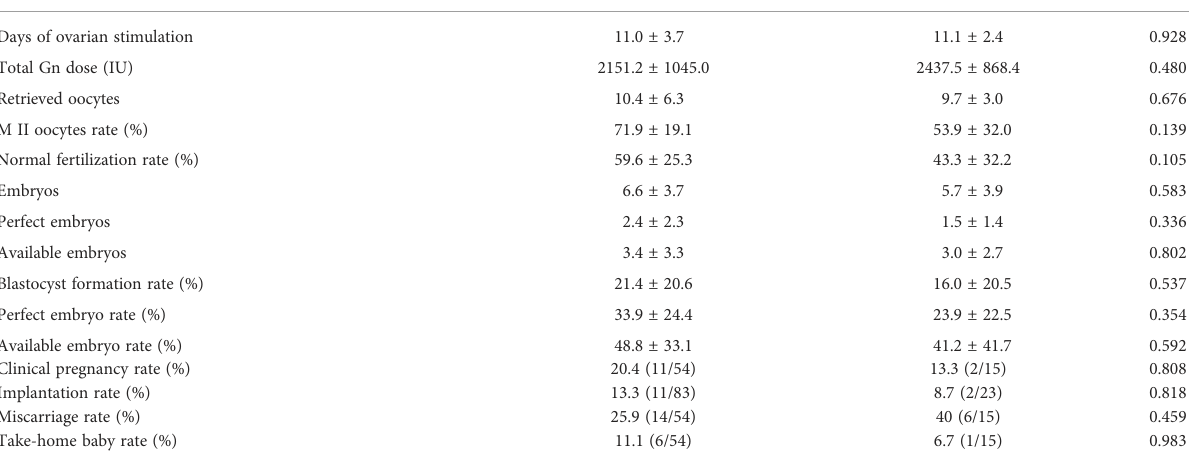
TABLE 4 Reproductive outcomes of IVF cycles in women with single APA vs. both APA antibodies in women with tubal etiology infertility. IVF laboratory outcomes and pregnancy